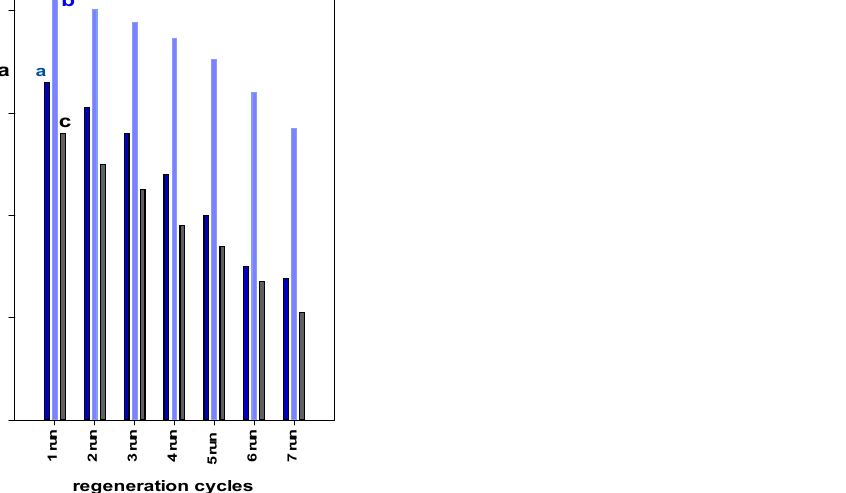
Figure 9. Reusability data of (a) Zr(3) ‐ PCH, (b) Zr(6) ‐ PCH, and (c) Zr(12) ‐ PCH materials using a BB ‐ 41 initial solution of 200 mg/L.